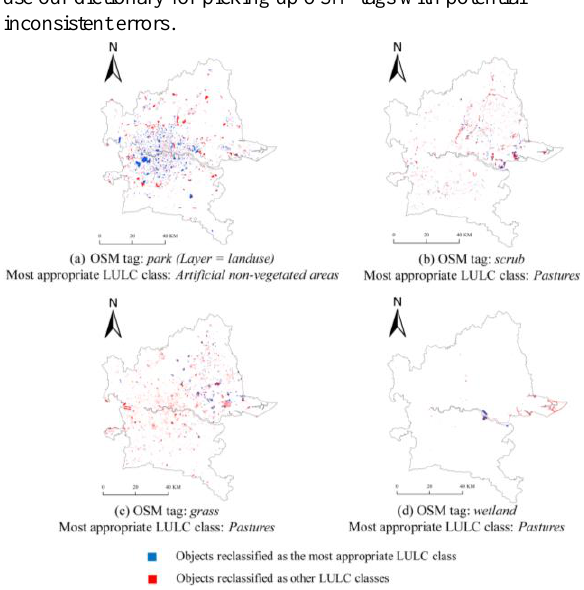
Figure 5 . Detecting inconsistent errors for several OSM